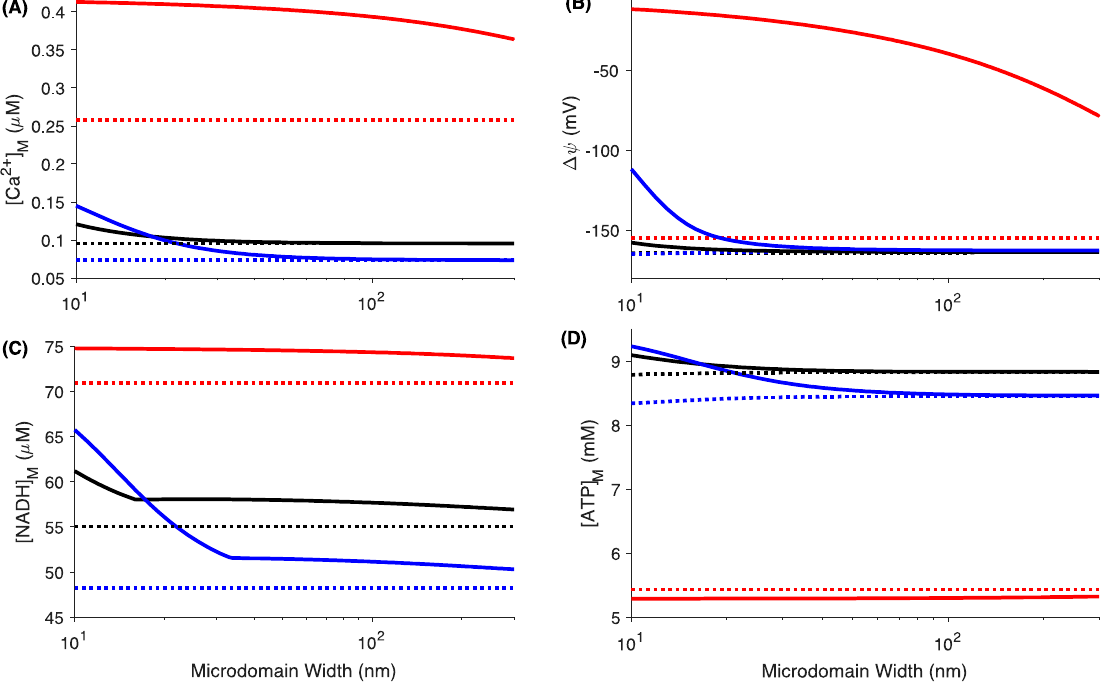
Figure 4. Changes in mitochondrial variables in response to the opening of a single IP 3 R channel at the single mitochondrion level. A single IP 3 R residing in the ER membrane is allowed to open for 100 ms starting at 100 sec, and the maximum changes in different mitochondrial variables are recorded. The resting value (dotted lines) and the maximum value after the channel opens (solid lines) of [Ca 2+ ] M ( A ), Δψ ( B ), [NADH] M ( C ), [ATP] M , and ( D ) in WT (black lines), MICU1 KO (red lines), and MICU2 KO cells (blue lines). Parameters used in the simulations are the same as given in the text. The value of V NaCa,max given by the model is 1.112, 1838.6, and 35.9675 μ M/s.